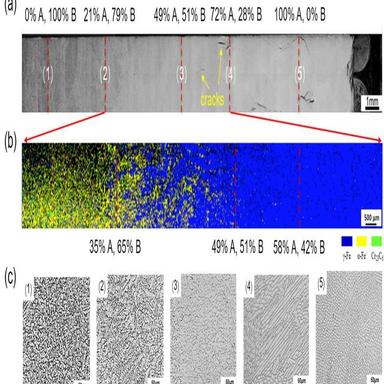
(a) Optical microstructure of the graded material. A and B represent SS316L and SS431 respectively; (b) EBSD phase mapping of the graded material ranging from 21 to 72 wt.% SS316L; (c) Magnified view of different zones on the graded material in (1,2,3,4,5).